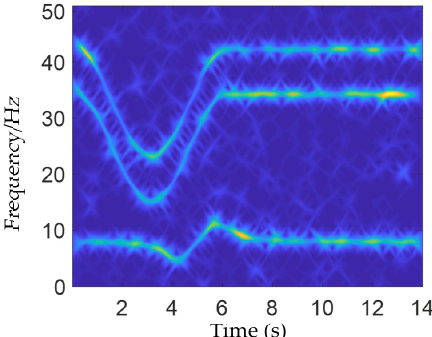
Figure 6. TF distribution of the simulated signal with noise based on GLCT.